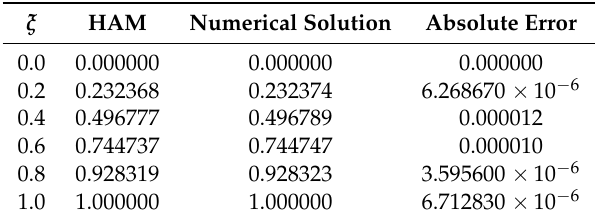
Table 1. Comparision of HAM and Numerical results for f ( ξ )